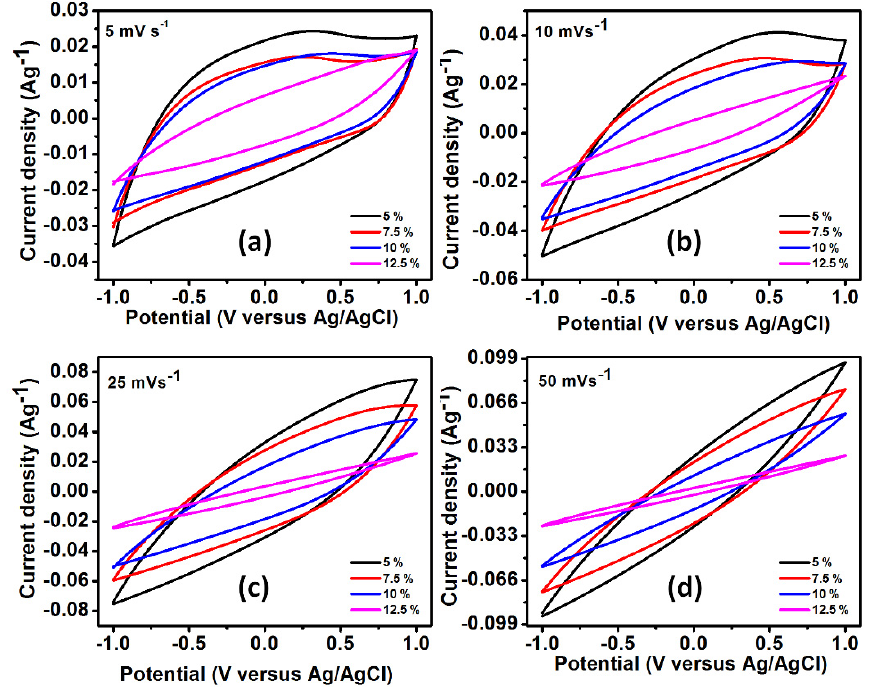
Figure 5. Supercapacitive behavior of synthesized electrode at different PVDF concentration for scan rate ( a ) 5 mV s − 1 , ( b ) 10 mV s − 1 CV, ( c ) 25 mV s − 1 CV, and ( d ) 50 mV s − 1 .